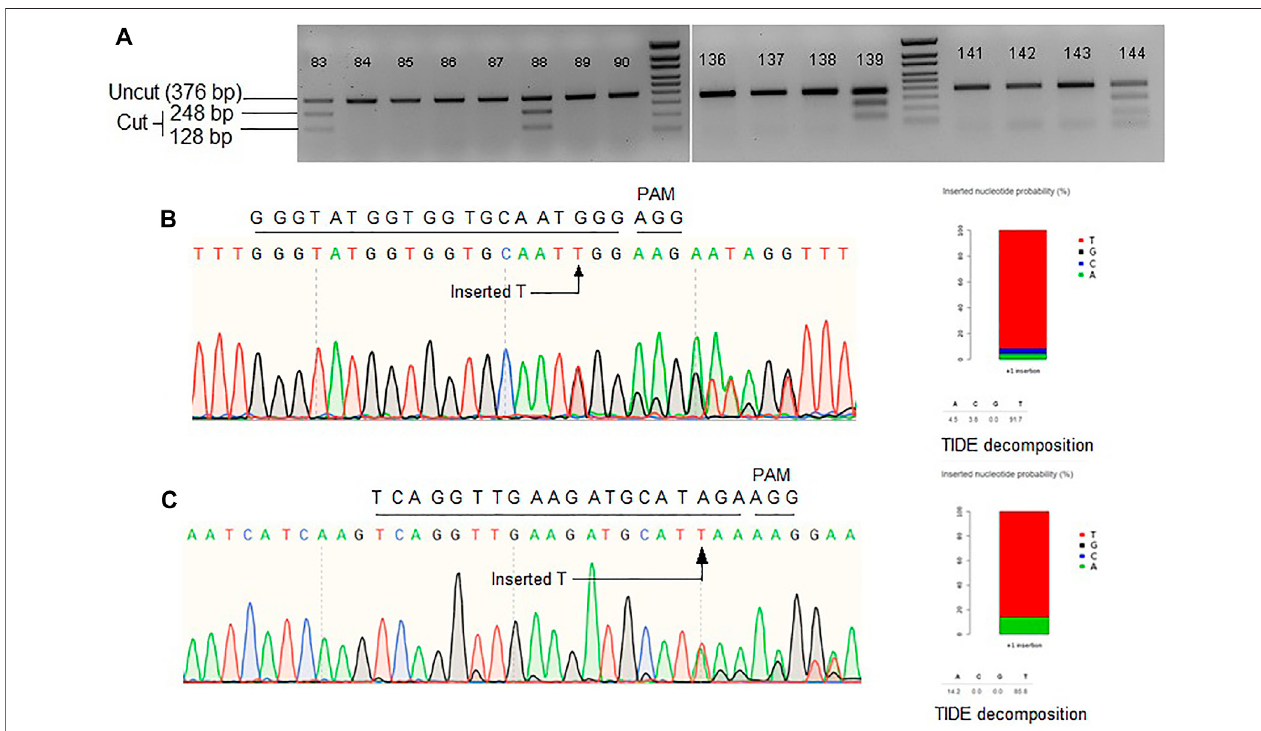
FIGURE 2 | (A) Representative gel images showing Mfe1 digestion of ALS product. Single T insertion at the cut point generates Mfe1 recognition site. (B) RepresentativeSangerchromatogramof ALS locus. (C) RepresentativeSangerchromatogramof Pita locus.TIDEdecompositionofthechromatogramin (B,C) showing single T insertion. Wild-type protospacer and PAM sequences are shown above each of the chromatograms.